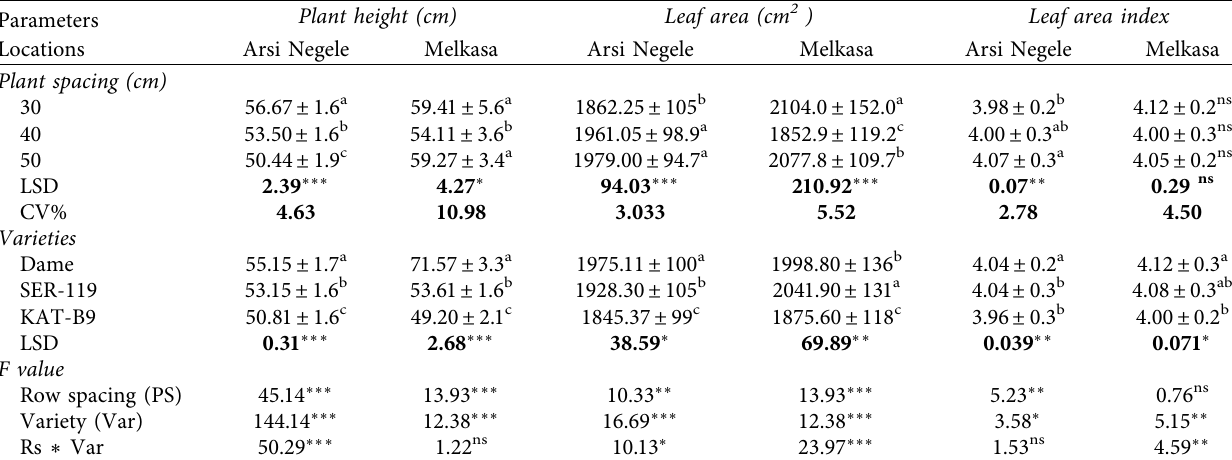
Table 3: Efect of interrow spacing on plant height, leaf area, and leaf area index of common bean varieties at the Arsi Negele and Melkasa sites.